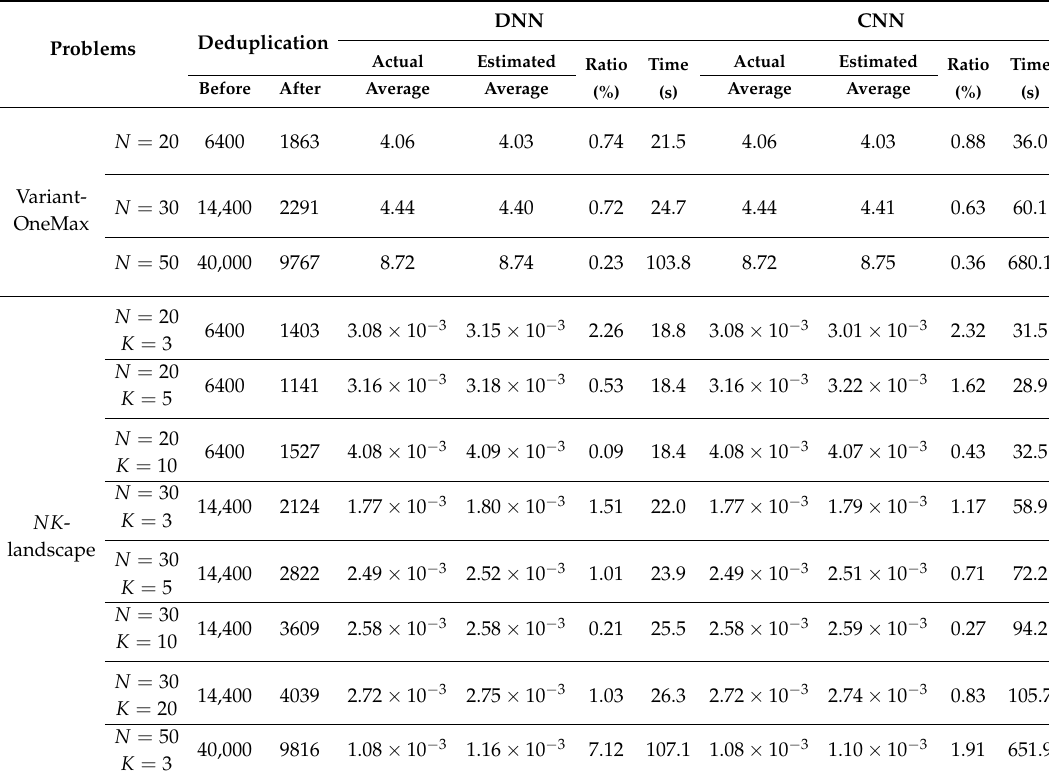
Table 2. Experimental results of epistasis estimation using DNN and